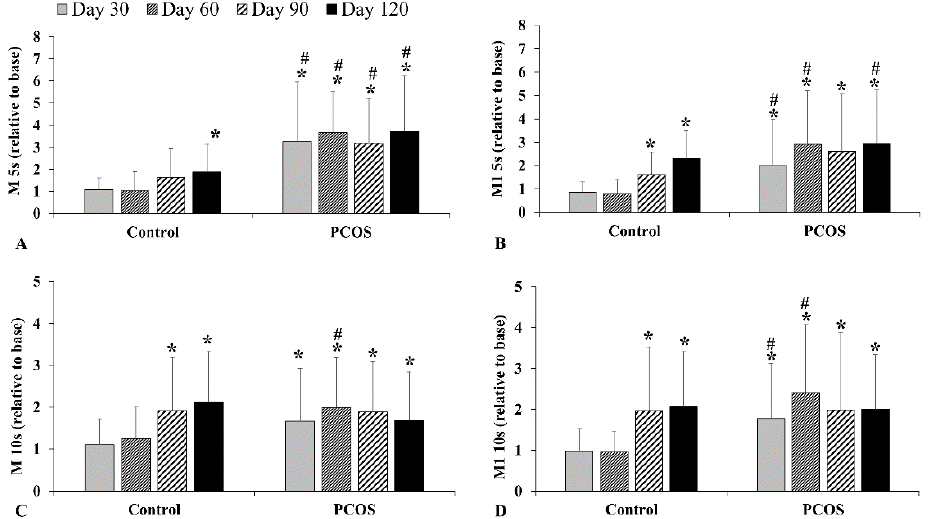
Figure 4. Alteration of red blood cell aggregation index parameters, such as M 5s ( A ), M1 5s ( B ), M 10s ( C ), and M1 10s ( D ). Means ± S.D.; * p < 0.05 vs. Base, # p < 0.05 vs. Control .